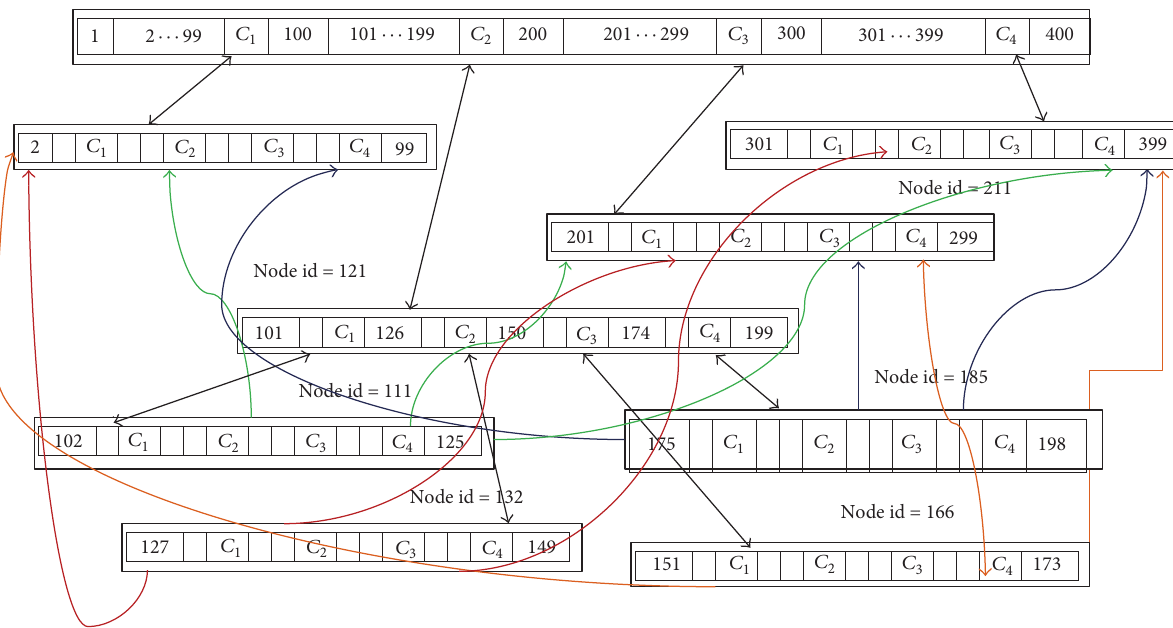
Figure 2: Anatomy of robust m-child family